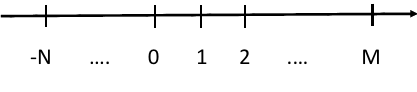
Figure A1. Project